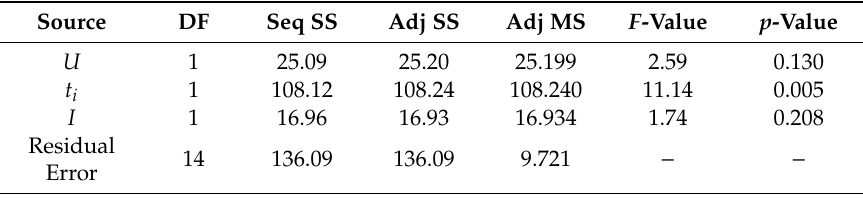
Table 11. ANOVA for the surface roughness parameter Rz .